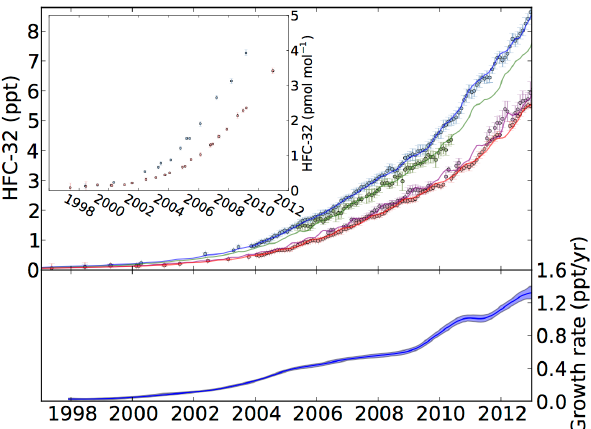
Figure 4. Semi-hemispheric monthly average HFC-32 mole frac- tions (30–90 ◦ N: blue; 0–30 ◦ N: green; 30–0 ◦ S: purple; 90–30 ◦ S: red). Averaged observations are shown as data points with error bars. The more sparse circles represent NH and SH air archive sam- ples, and are highlighted in the inset box. The solid trend lines were calculated using a 12-box model with emissions from the inversion as input. The lower plot shows the annual running mean global mole fraction growth rate.